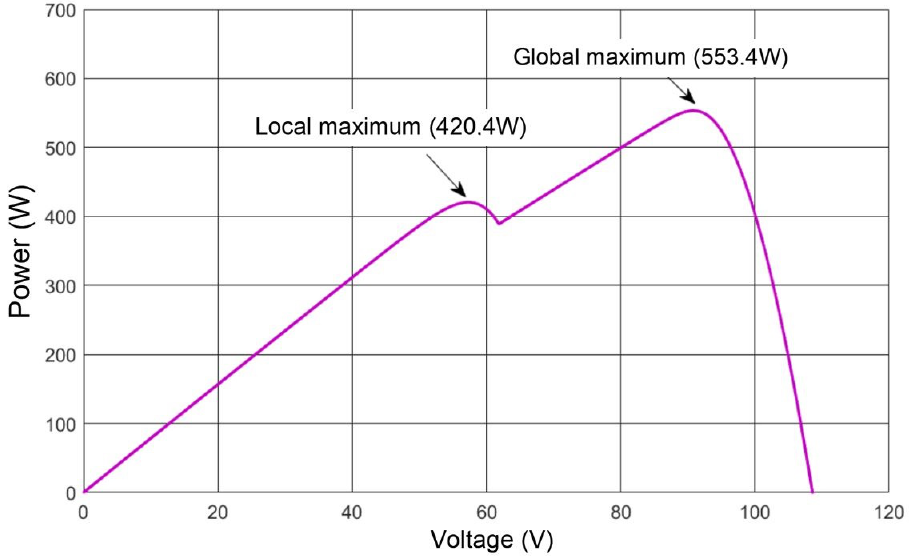
Figure 11. P-V characteristic of the PV array with partial shading from Step